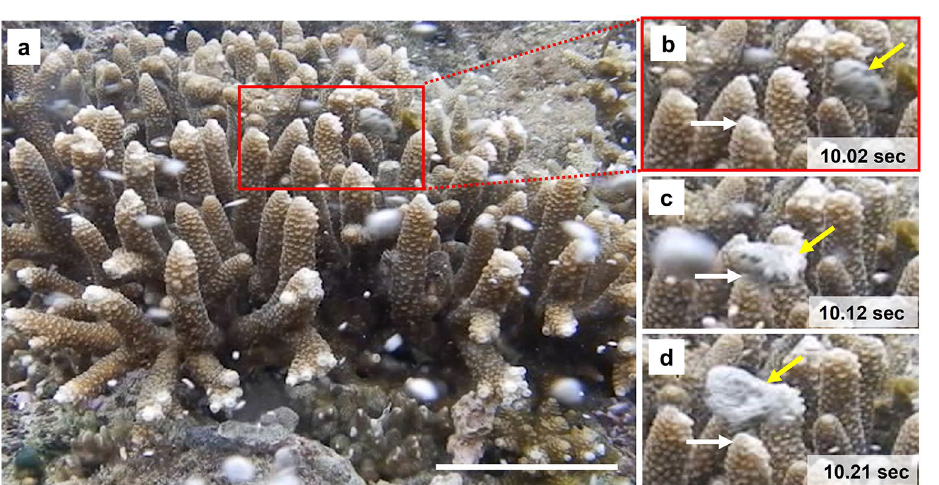
Figure 7. Underwater photography showing that pumice stones hit coral branches. Underwater photographs showing the possible damage of corals by the ablation of pumice stones in a shallow coral reef environment. ( a ) Pumice pebbles are shown drifting around the coral and driven fast by wave action. This figure corresponds to Supplementary Video 4. Scale bar: 5 cm. ( b – d ) A pumice stone with a long axis of approximately 2 cm (yellow arrow) contacted the tip of a coral branch (white arrow) and changed its direction within a short period. The images were taken less than 50 cm below the sea surface. These photos were taken on 14 November